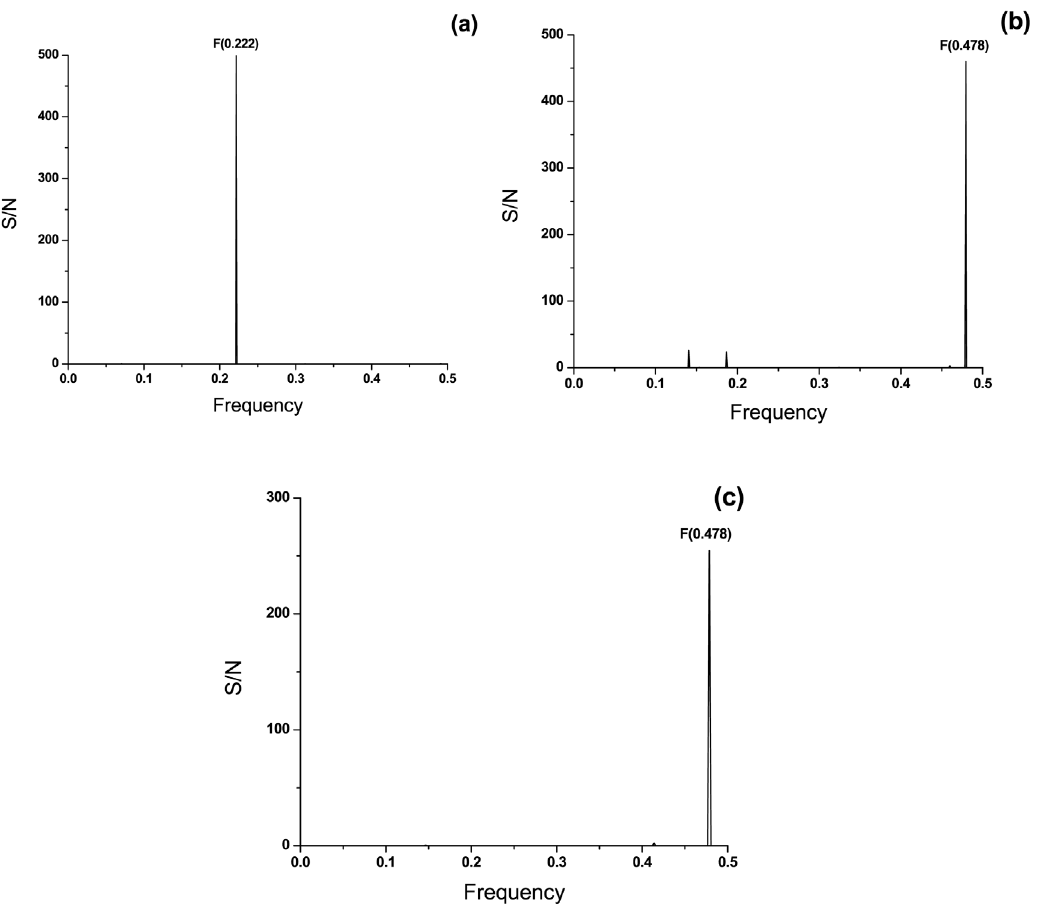
Figure 5. CS of S1 proteins from SARS-CoV and SARS-CoV-2 and actin proteins. ( a ) CS of S1 proteins from human SARS-CoV; ( b ) CS of S1 proteins from SARS-CoV-2; ( c ) CS of mammalian actin proteins. The abscissa and the ordinate are as described in Figure